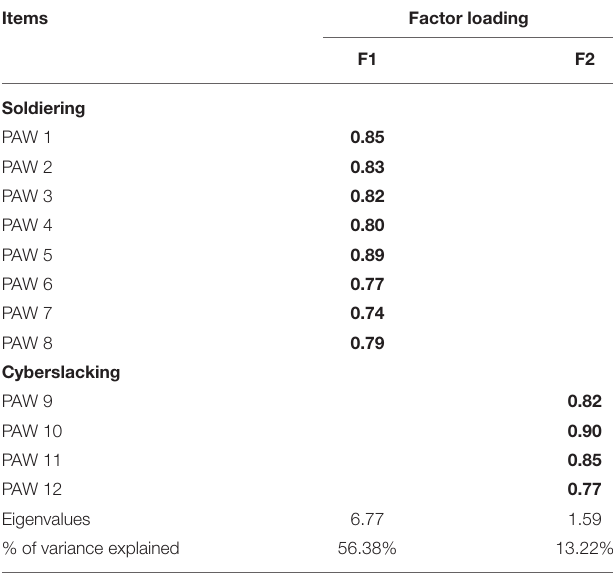
TABLE 1 | Results of the exploratory factor analysis on the PAWS in Sample A.